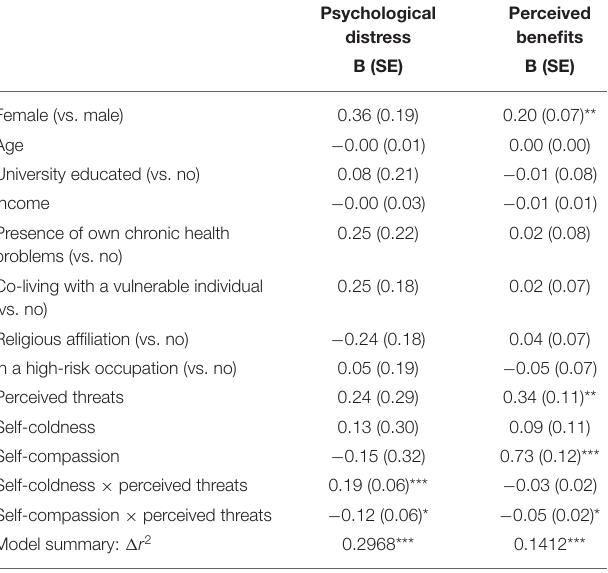
TABLE 3 | Results of moderation models ( N = 761).